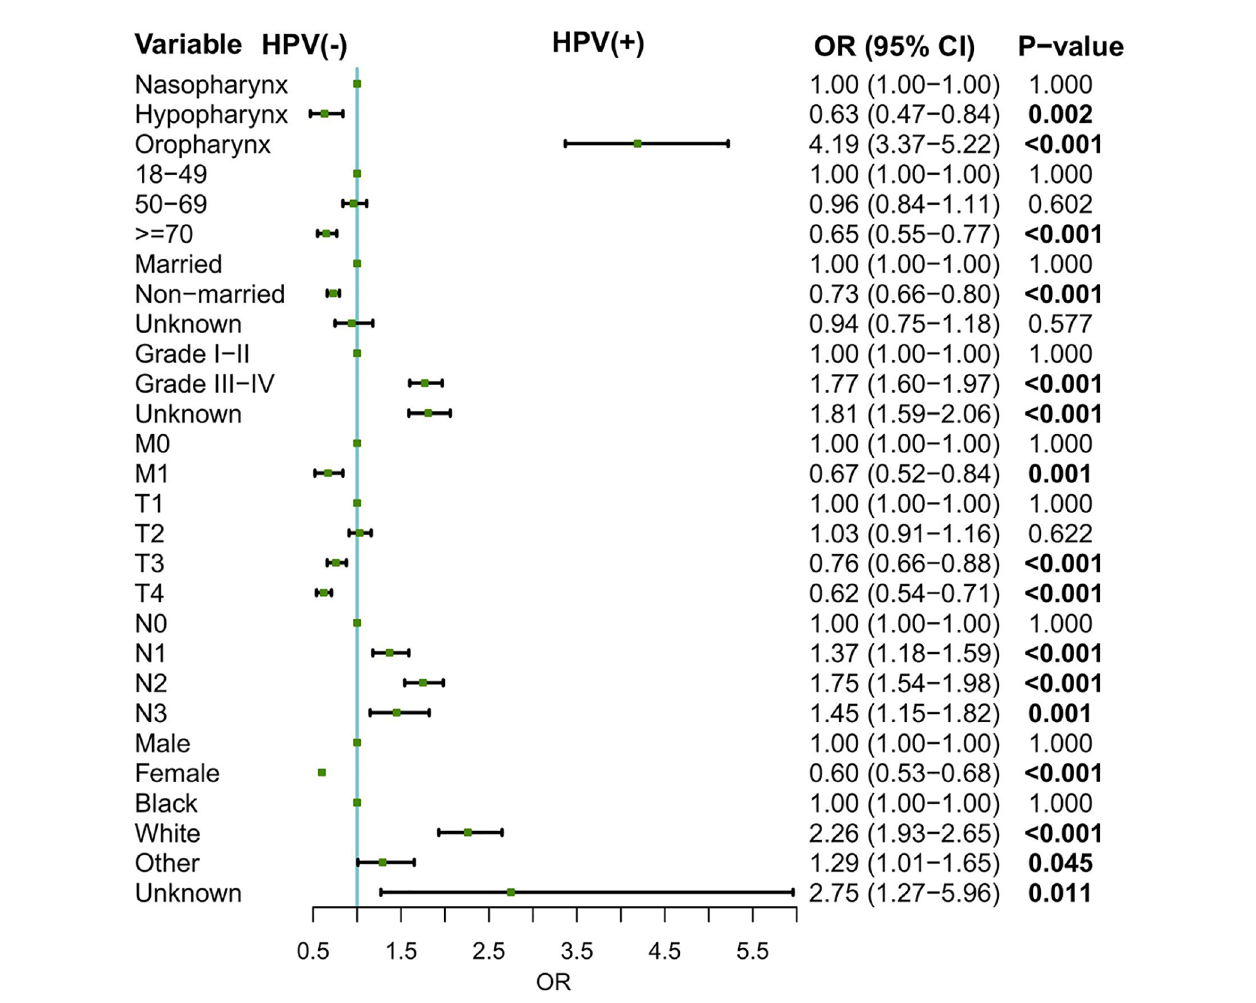
FIGURE 1 | Associations between patient characteristics and HPV status. HPV, human